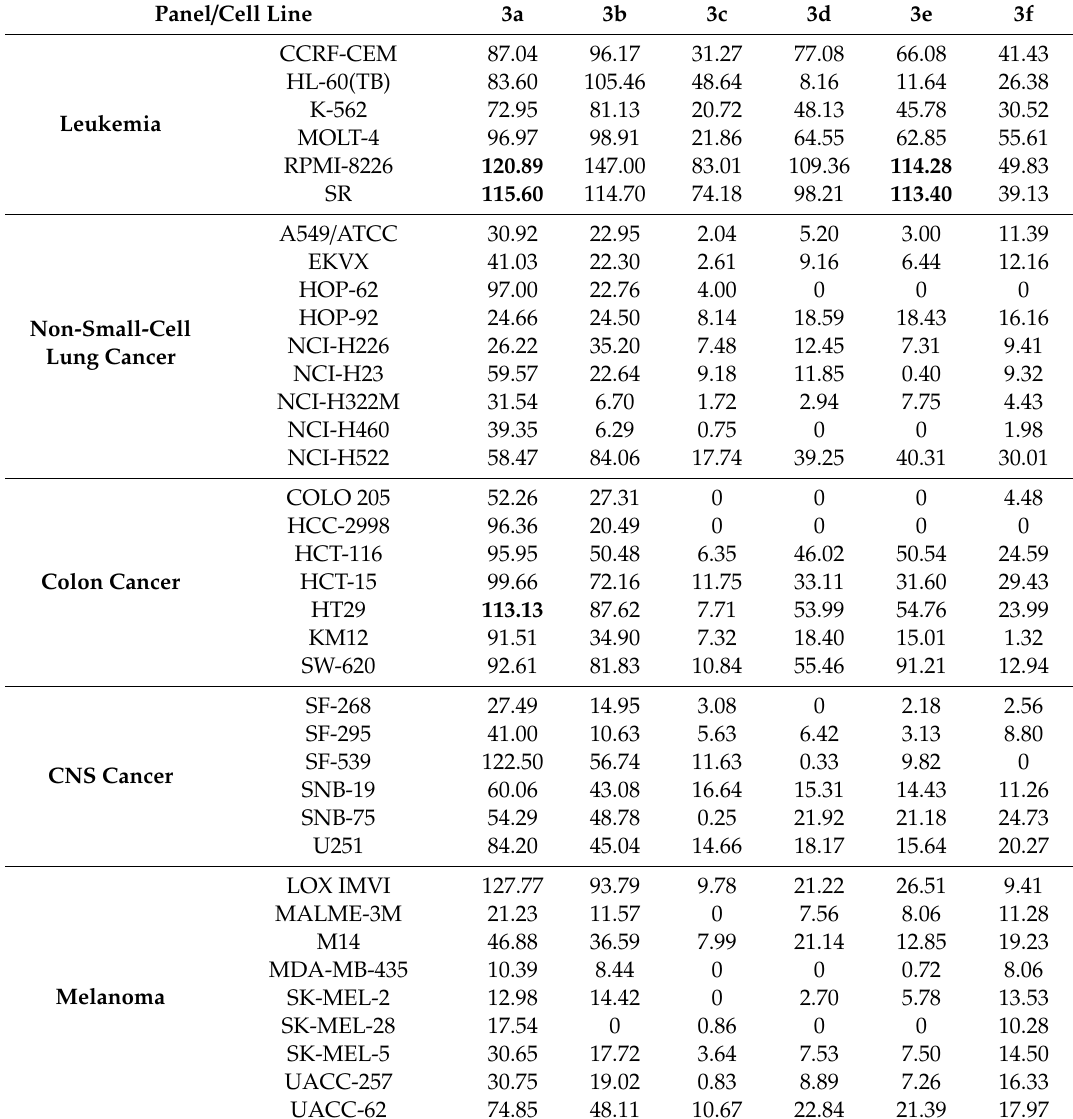
Table 1. Growth inhibition percentage of compounds 3a – f (concentration 10 − 5 M) against di ff erent cell